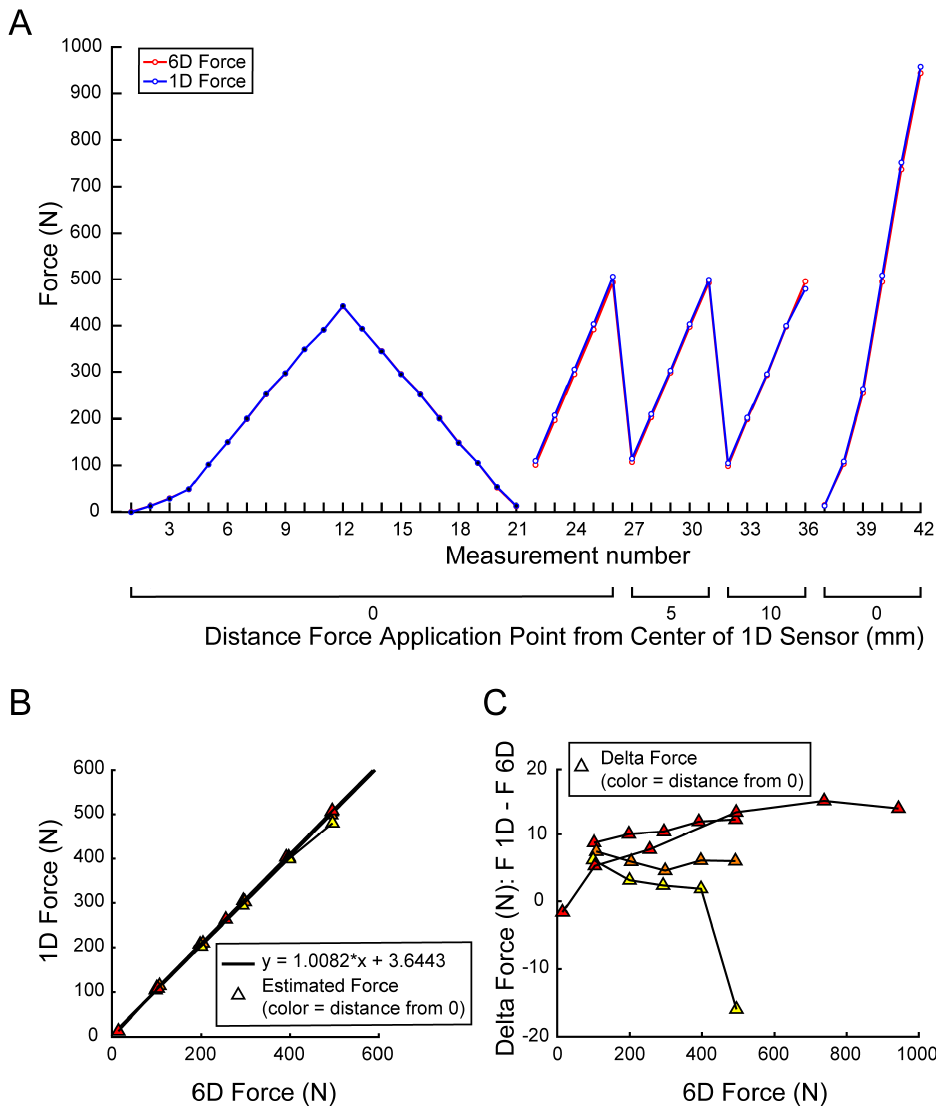
Figure 7. Calibration results. ( A ) Calibration and test session curves. Estimated force recorded with the 6D load cell (red), and the estimated force recorded with the 1D sensor (blue), are reported in the function of the application point distance from the center of the 1D load cell. Black dots are the records used for the calibration; white dots are the data used for the test. ( B ) Compares the 1D load cell estimated force with the 6D load cell one. ( C ) Delta force (1D − 6D estimated force) in function of the 6D one. Triangle color indicates the distance of the force application point from the center of the 1D sensor (yellow: 10 mm; orange: 5 mm; red: 0